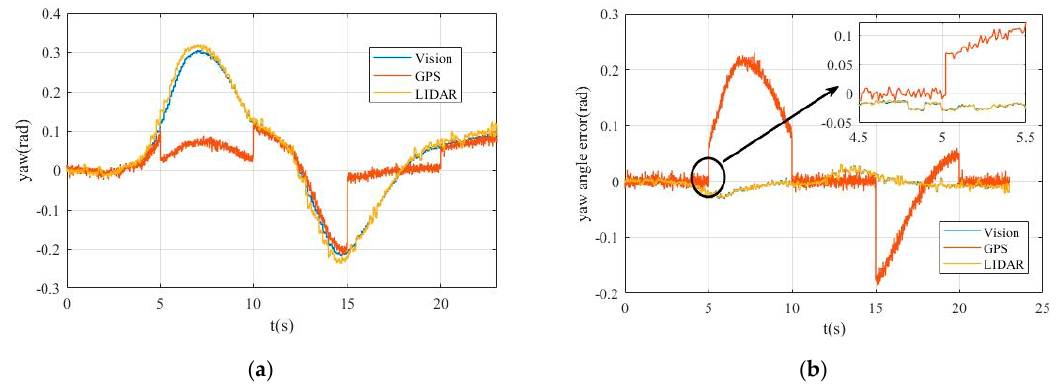
Figure 12. The yaw angle changes in experiment: ( a ) detected yaw angle using different sensors; and ( b ) the yaw angle error.